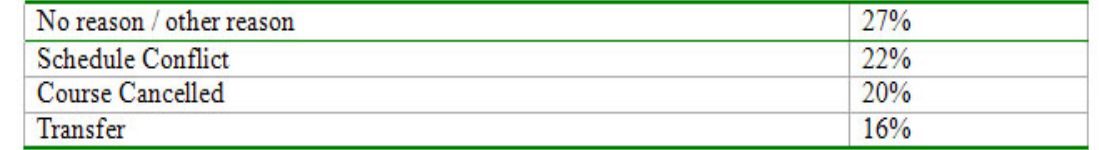
Table 10 . Top four reasons for withdrawal from onground classes, accounting for 85 percent of the